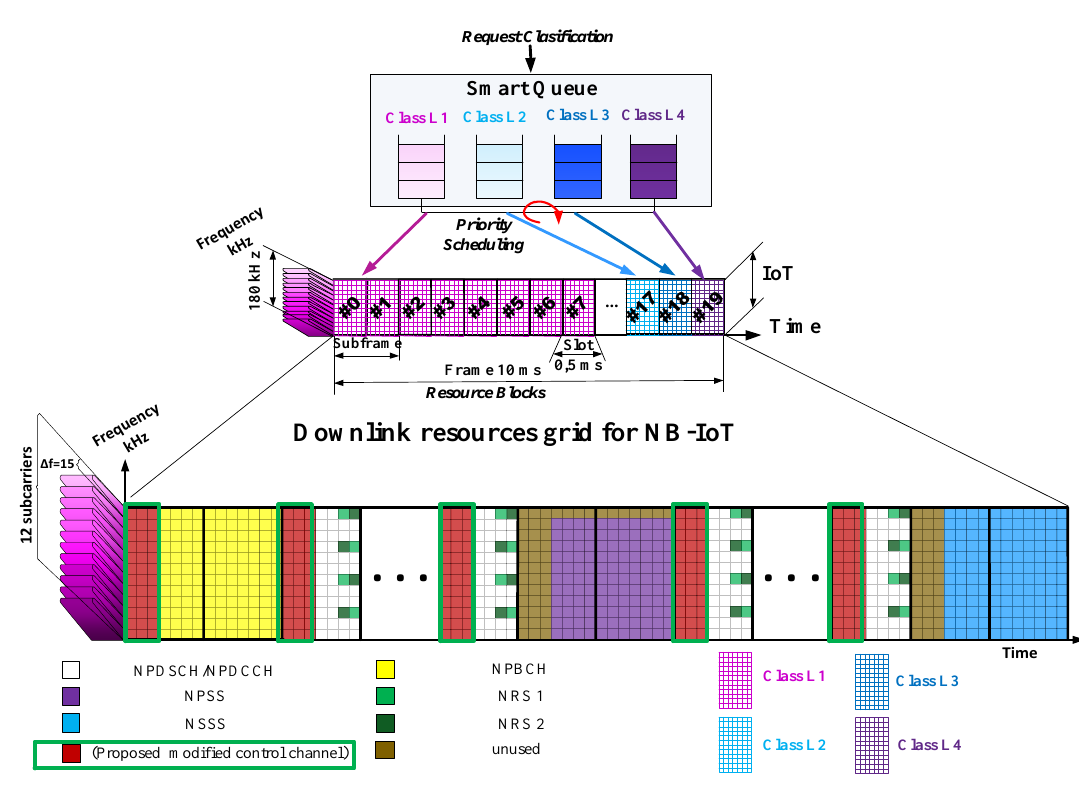
Figure 7. Resource grid of LTE/IoT for the downlink channel.